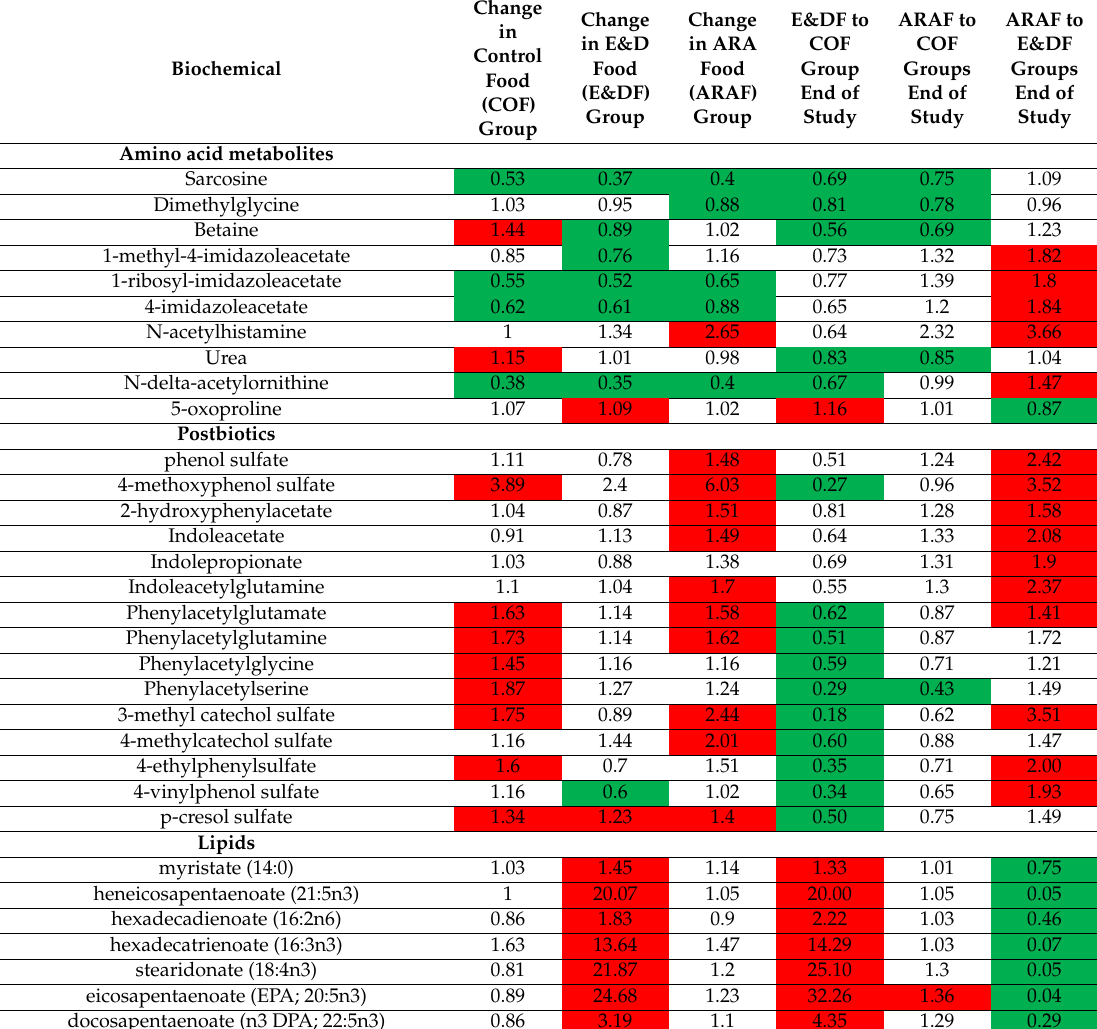
Table 5. Change in or end of study di ff erence in selected analytes from plasma metabolomics screening of cats eating control food (COF), or test food 1 (E&DF) COF enhanced with EPA and DHA from fish oil, or test food 2 (ARAF) COF enhanced with arachidonic acid from chicken